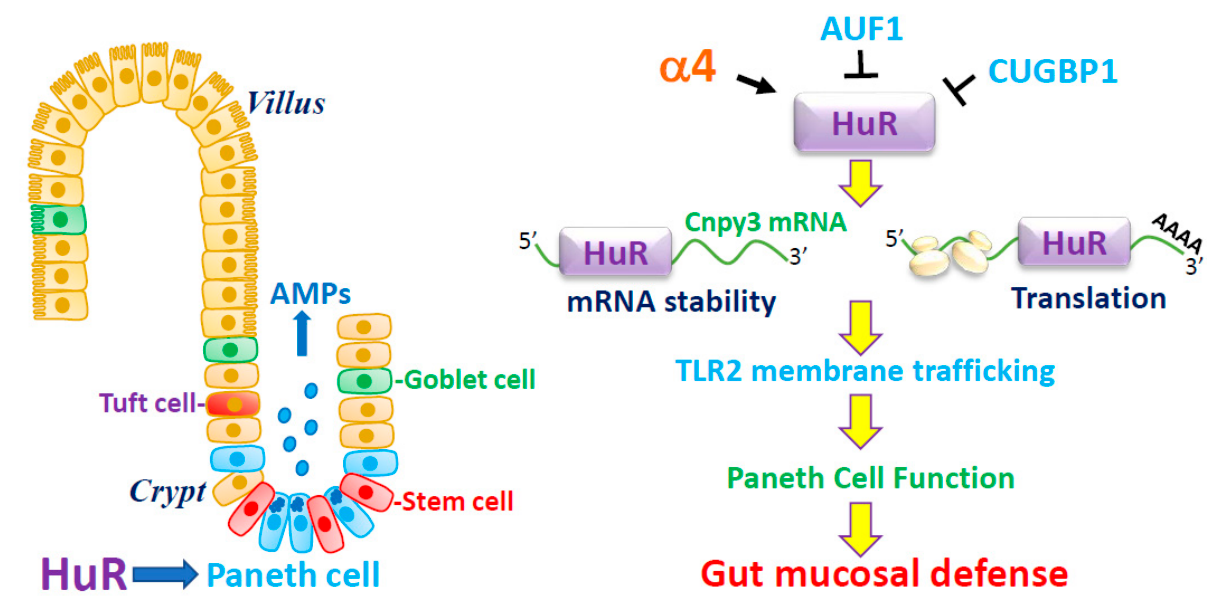
Figure 1. HuR modulates Paneth cell function by controlling membrane distribution of TLR2 through posttrascriptional control of CNPY3. AMPs, antimicrobial proteins. HuR enhances CNPY3 expression by inducing the stability and translation of Cnpy3 mRNA via association with its 3 ′ -UTR. Induced CNPY3 is essential for the proper membrane localization of TLR2 in the intestinal epithelium, thus sustaining Paneth cell activity. HuR level is positively regulated by α 4, but its binding affinity is downregulated by CUGBP1 and AUF1. Disruption of HuR function leads to defective Paneth cells, compromises the intestinal epithelial defense and renewal, and impairs the barrier function.